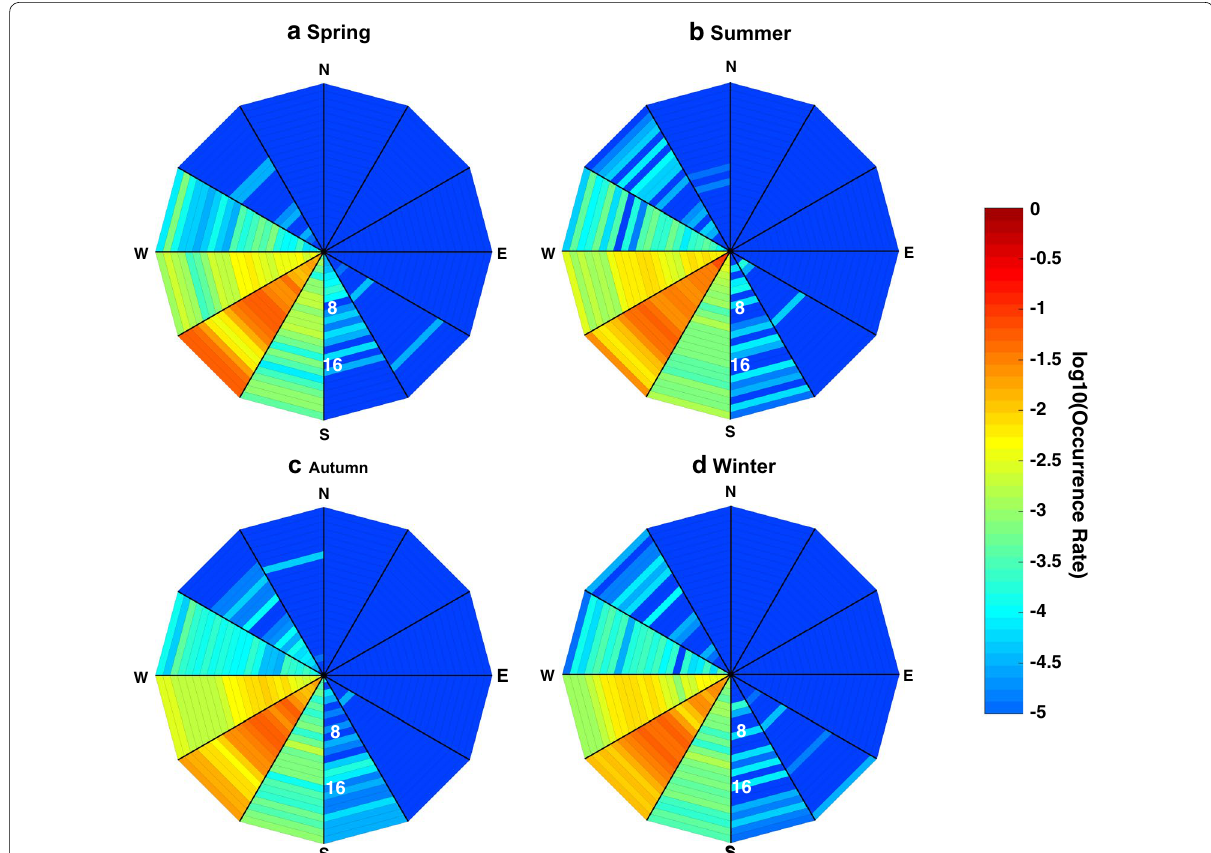
Fig. 5 LT variations in propagation directions of MSTIDs for spring, summer, autumn and